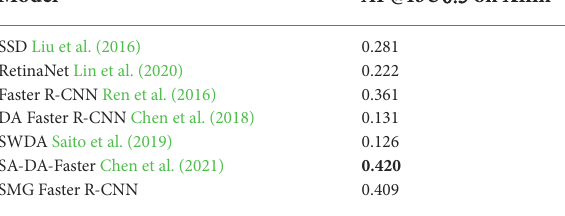
TABLE 1 Results comparison on real xilin